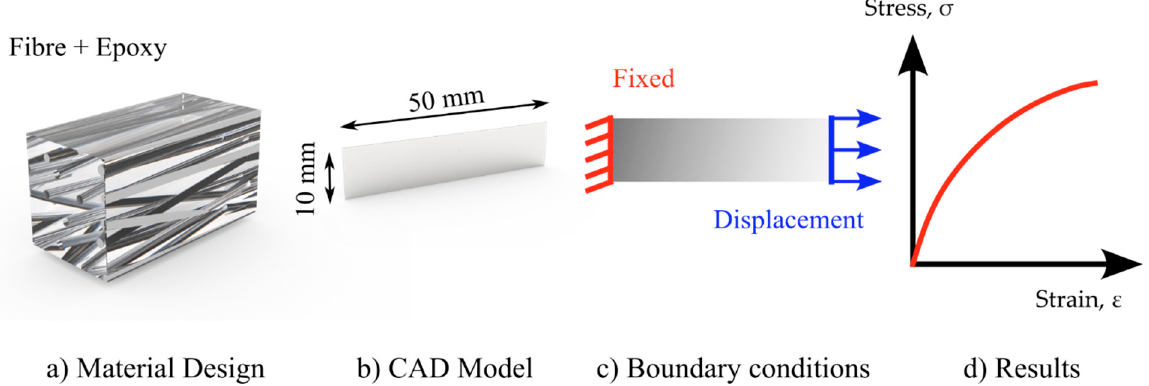
Figure 3. Procedure of the numerical simulation; ( a ) Material design of fiber reinforced epoxy ( b ) CAD model with the size of tested specimen ( c ) Applied boundary conditions to the model, one end fixed and displacement at another end ( d ) Stress-Strain graph obtained as a results